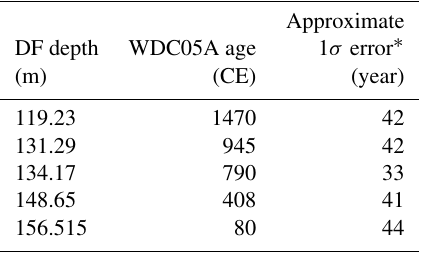
Table 6. Age control points for the Dome Fuji (DF) core from CH 4 matching to the WAIS Divide core (WDC)